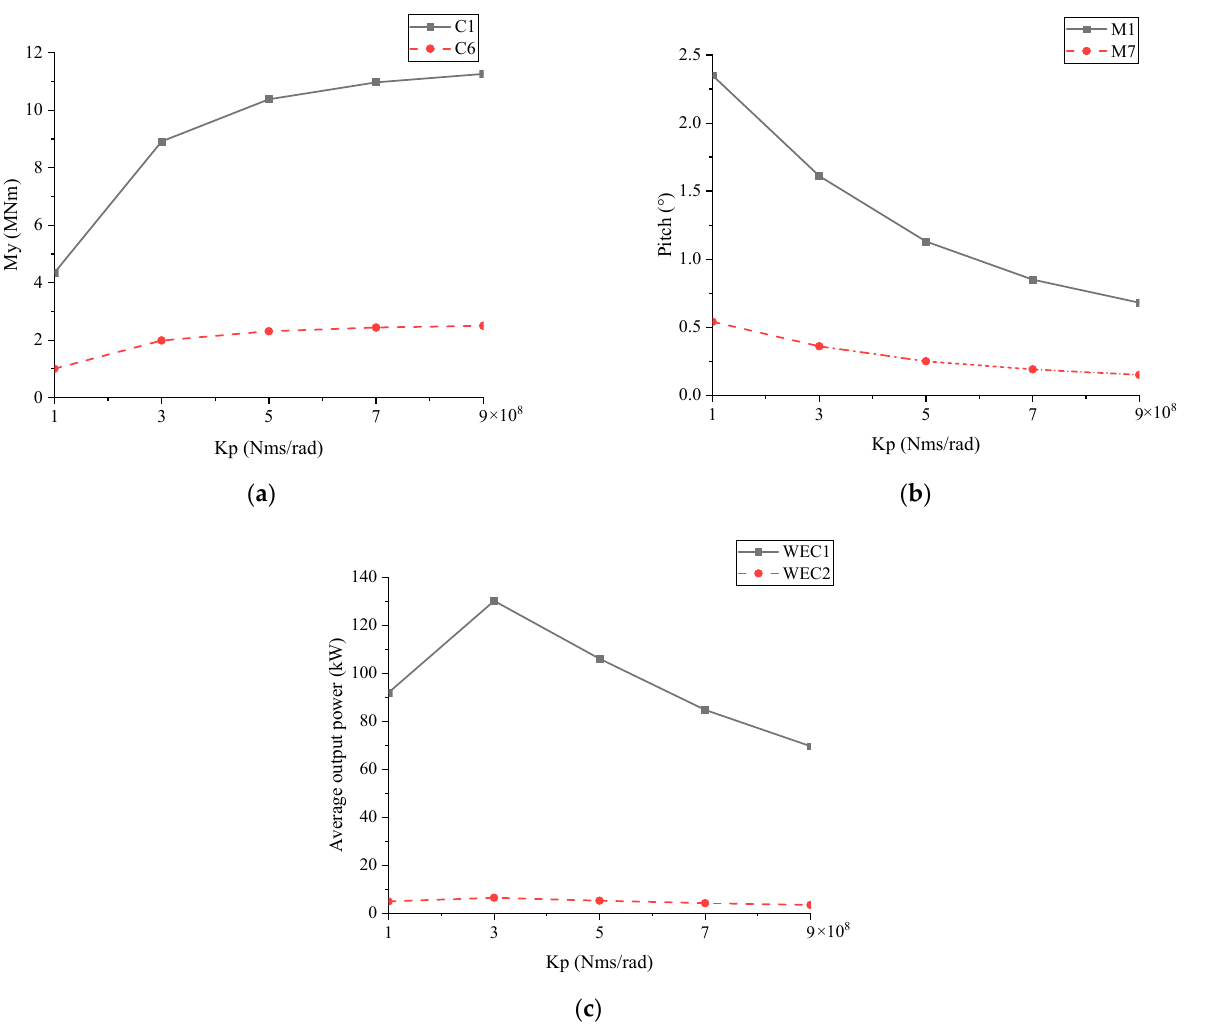
Figure 4. Effect of the Kp on WECs’ performance: ( a ) pitch bending moment; ( b ) pitch; ( c ) average output power.